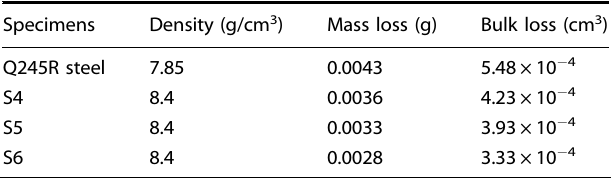
Table 4. The corresponding open-circuit-potential of Q245R steel substrate and Inconel 625 coatings: S4, S5, S6.